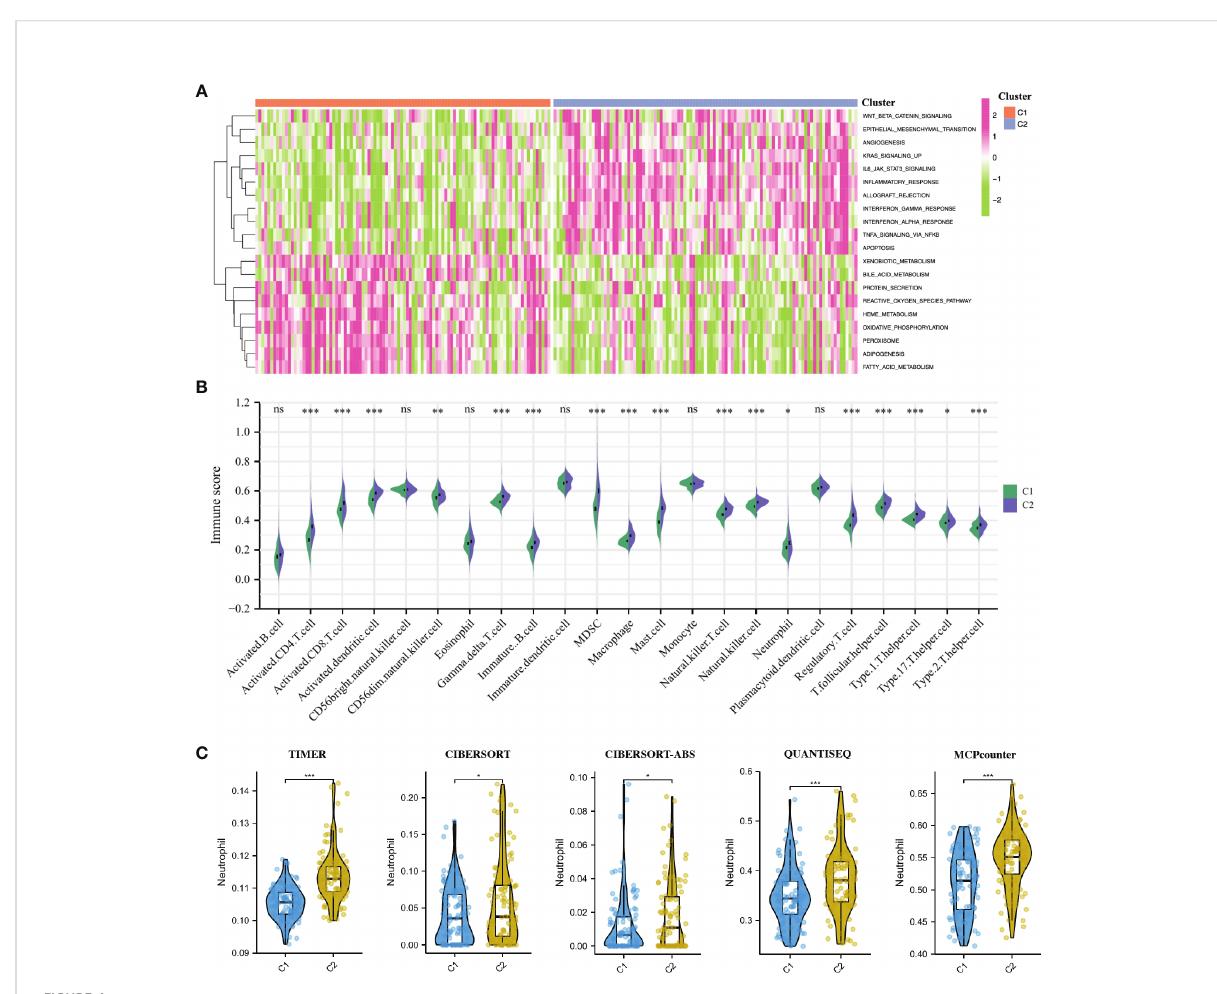
FIGURE 4 GSVA enrichment analysis and immune in fi ltration analysis of IRI clusters. (A) : The heatmap showing the different hallmarks between the two clusters. (B) Pod-plot showing the in fi ltration of 23 types of immune cells between the two clusters. (C) Comparison of the in fi ltration of neutrophils between clusters using other fi ve algorithms. GSVA, gene set variation analysis. *P < 0.05, **P < 0.01, ***P < 0.001; ns, no signi fi